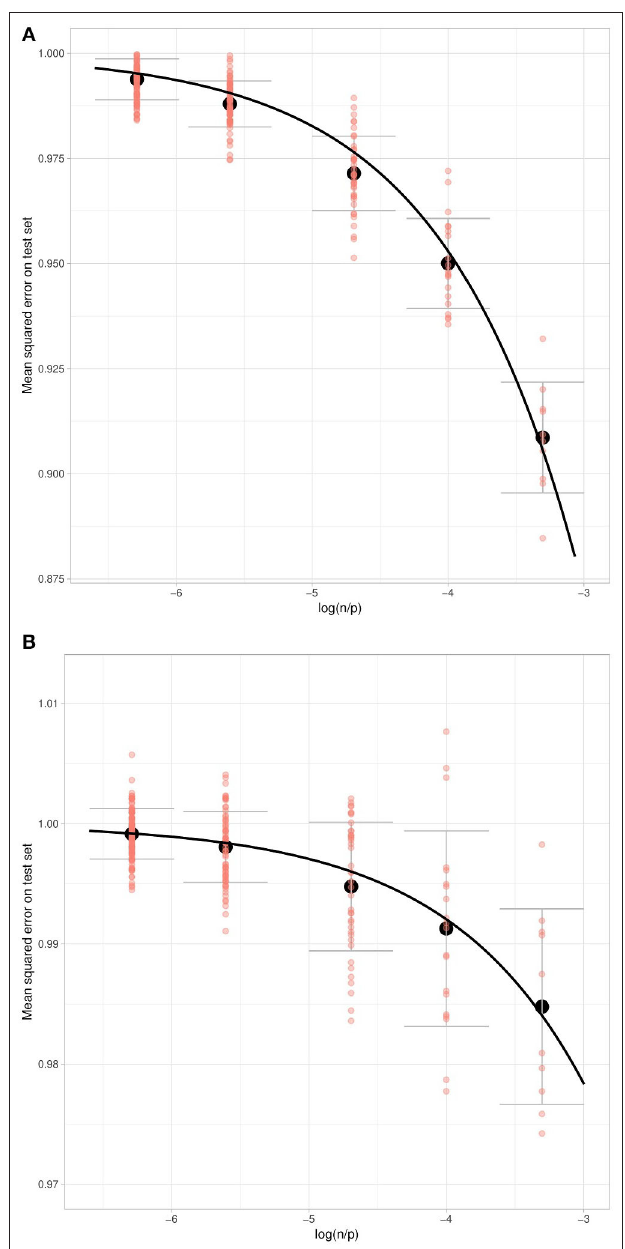
FIGURE 8 | Normalized Mean Squared Error on the test set for the prediction of Height (A) and BMI (B) with respect to the log ratio of the number of individuals over the number of markers in the training set. Salmon dots correspond to training set replications, black dot to the mean of replications for different ratio and we show one standard deviation (over the training sets) of the mean test set error. The theoretical curves are fitted using the estimated heritability and an effective number of